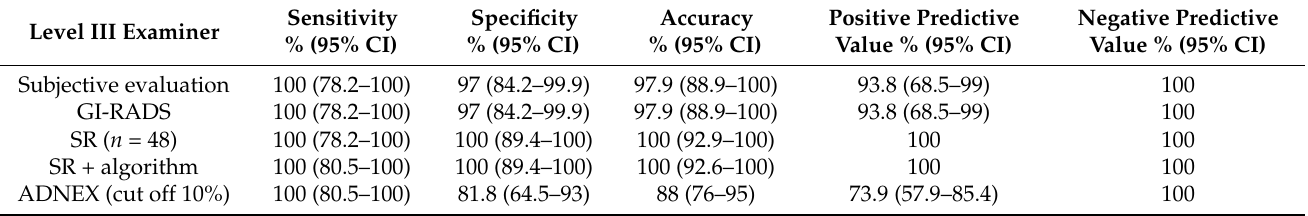
Table 2. Diagnostic performance of models based on expert’s (level III) evaluation.